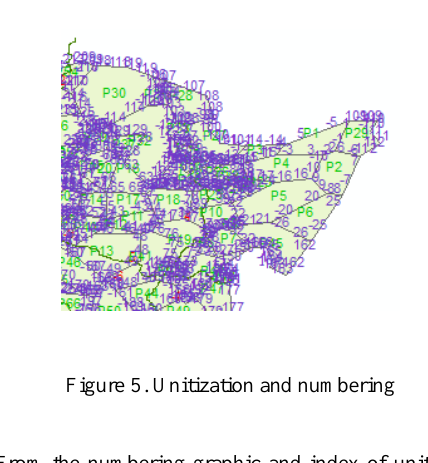
Figure 9. Operation